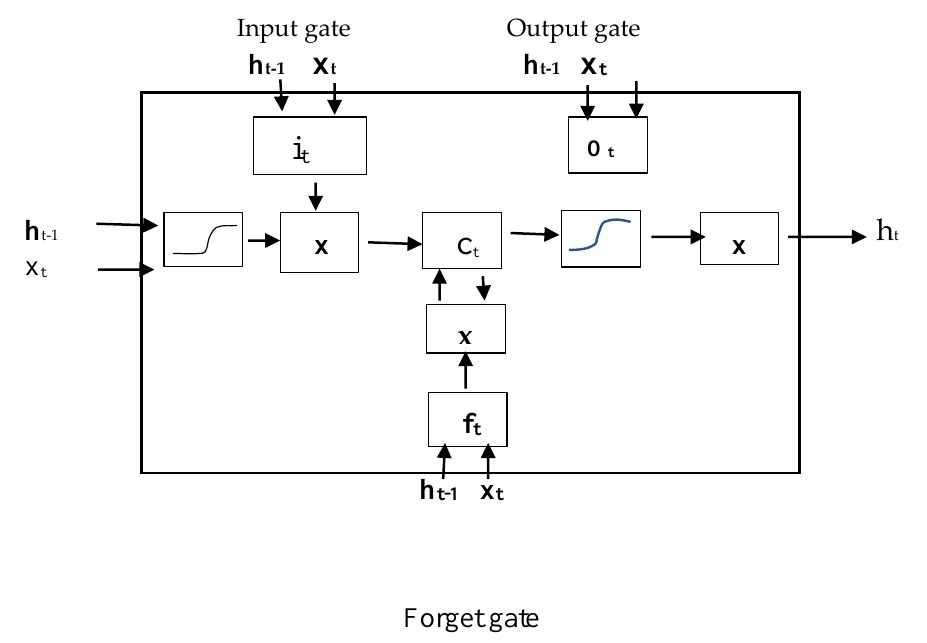
Figure 3. Description of LSTM cell configuration.